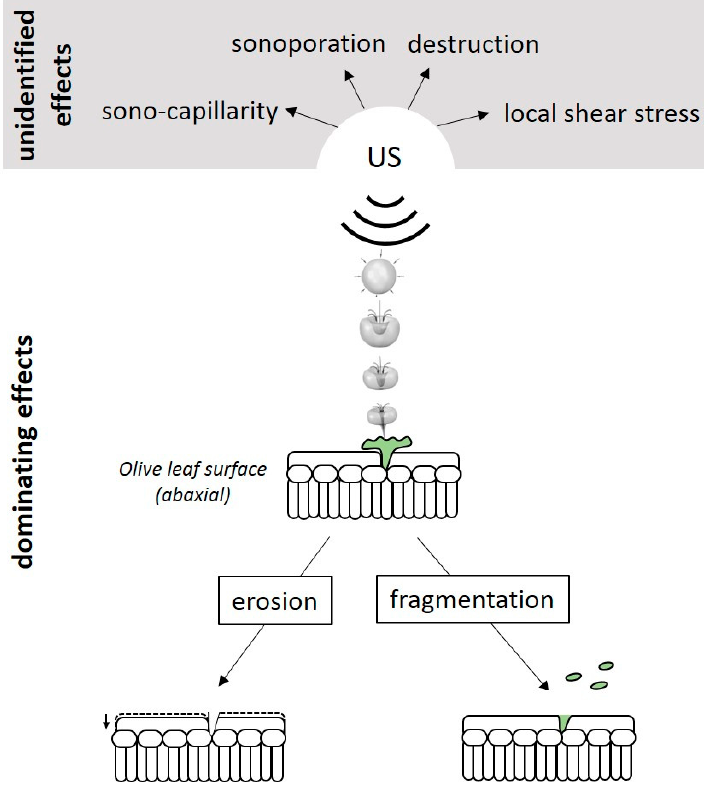
Figure 4. Evidenced mechanisms of the effect of acoustic cavitation on leaf surface modification.